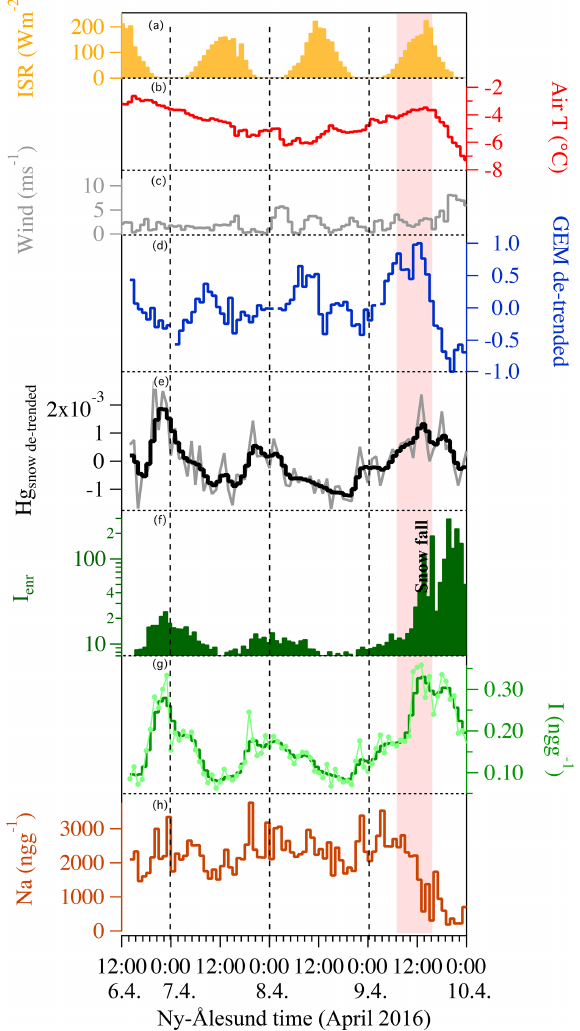
Figure 3. The 2016 experiment took place when a day and night cy- cle was available. Iodine concentration ( g – light green line for the raw data and green light for the three-point smoothing) exhibited a diurnal variability (except during the snowfall event), not detected for sodium ( h – dark red line). The iodine enrichment factor ( f – dark green solid line) also exhibited a diurnal cycle and highlights the effect of snowfall on iodine concentration in surface snow (pink shading shows the snowfall event). De-trended GEM ( d – blue line) and the surface snow de-trended total mercury concentrations ( e – grey lines for raw data and black line for the three-point smooth- ing) show opposing diurnal patterns. Additional information can be found in Fig. 4. Air temperature does not show a pronounced di- urnal cycle ( b – red line) connected with incoming solar radiation (ISR) ( a – yellow solid). Wind speed is shown in grey (c) . Dashed vertical lines indicate local midnight.